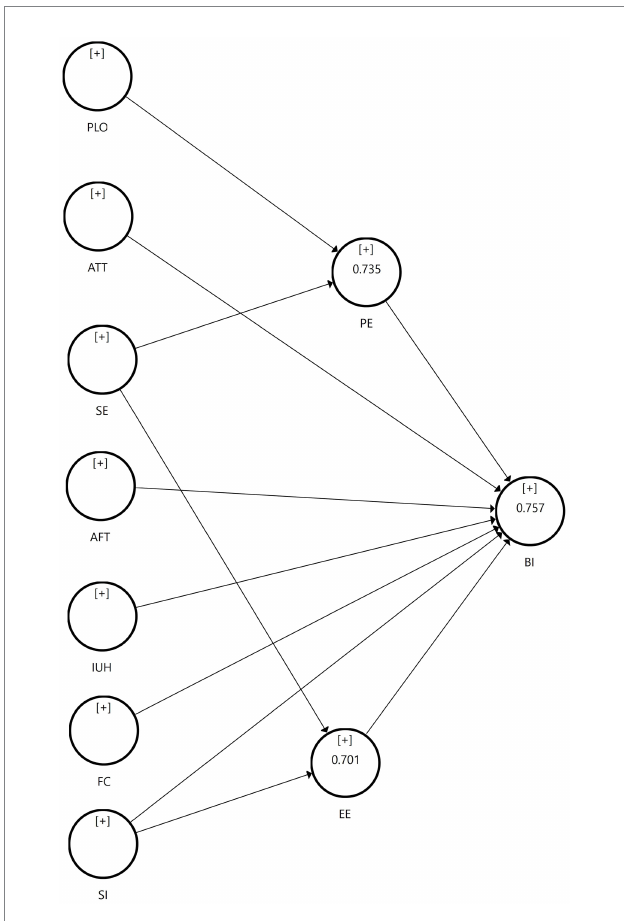
FIGURE 2 Final model with R 2